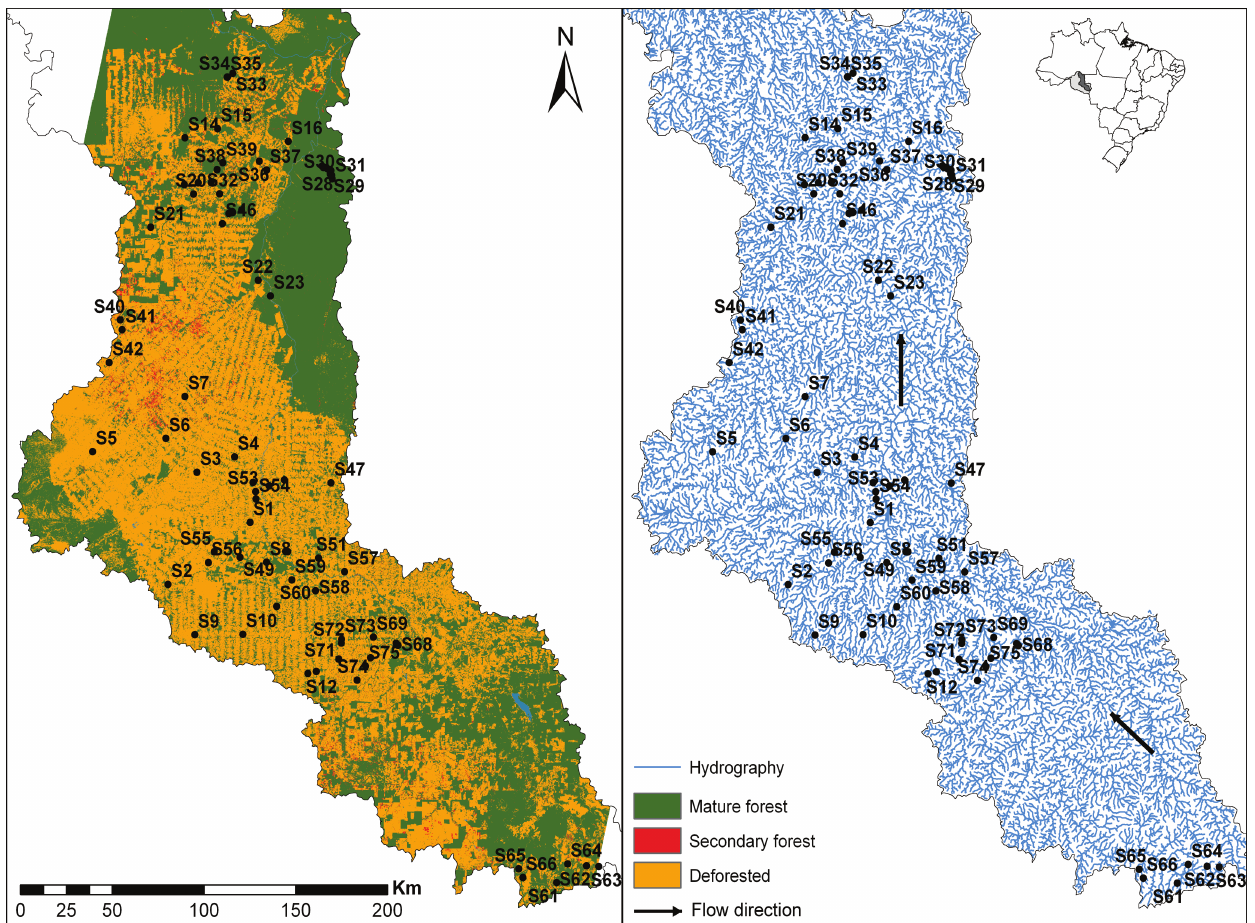
Fig. 1. Sampled sites along the rio Machado basin and the three main types of soil coverage (left). Hydrography of the rio Machado basin and flow direction of the rio Machado